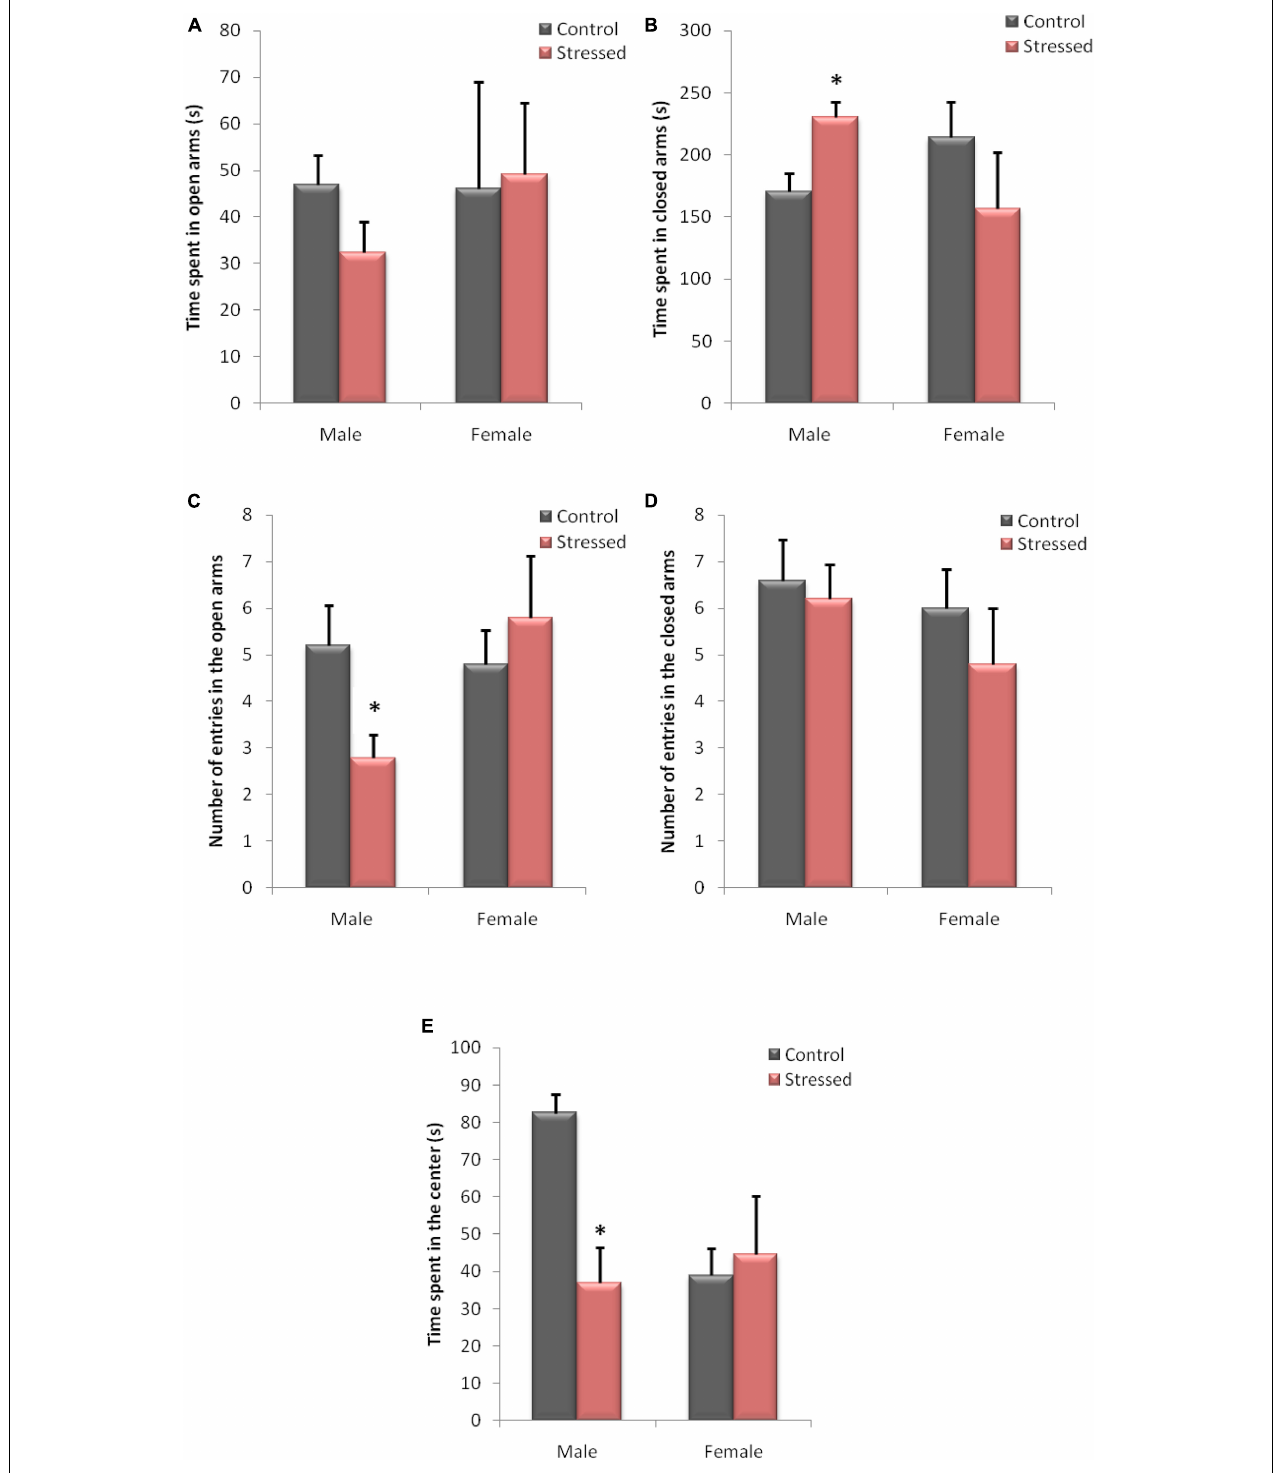
FIGURE 7 | Behavioral evaluation of anxiety-like behavior in male and female rats in an Elevated plus Maze. The behavior of the animals was recorded by a videotracking system. In male rats, chronic intermittent cold stress causes an increase in the time spent in closed arms (B) , with a decrease in the time spent in the center (E) . It also leads to a decrease in the number of entries in the open arms. Cold exposure had no significant effect on the various variables measured during this test in female rats. (A) Time spent in open arms; (B) time spent in closed arms; (C) number of entries in open arms; (D) number of entries in closed arms; (E) time spent in the center. Each histogram represents the mean ± SEM; effect of stress: ∗ ns p < 0.05, ns: (not significant) p > 0.05 ( n = 5).